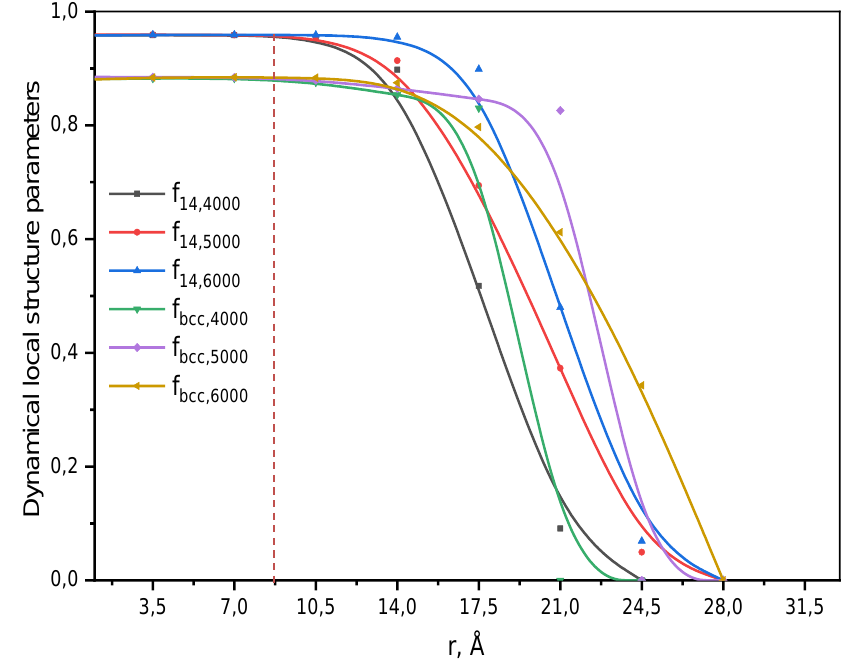
Figure 8. Dynamical local structure parameters <f 14 >, <f bcc > for 4000, 5000, 6000 atoms sample through concentric